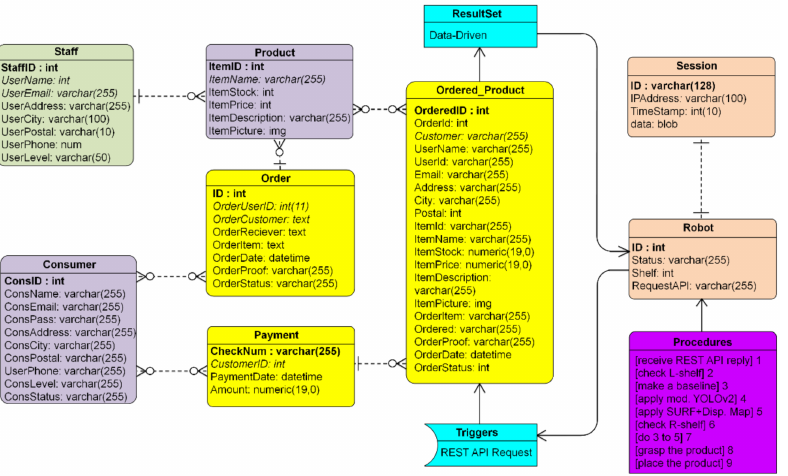
Figure 4. The ERD of the whole database in an online shop with REST API request and data-driven mode.